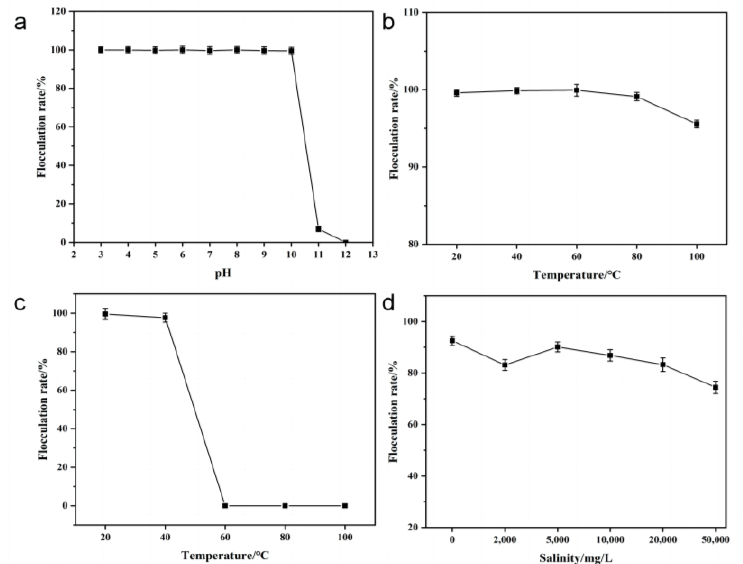
Figure 4. The effect of pH on the flocculating activity of HL1-FB ( a ); the thermal stability of HL1-FB ( b ); the working temperature of HL1-FB ( c ); and the effect of salinity on the flocculating activity of HL1-FB ( d ).